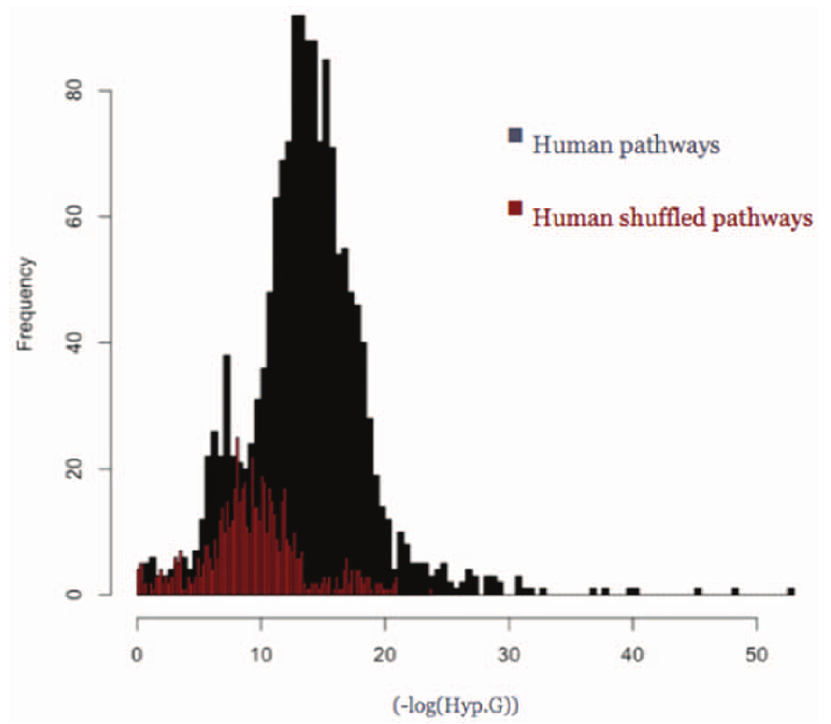
Figure 4. Motif occurrence Hyper-geometric distribution. Hyper-geometric p-value distribution for the number of motif occurrences in true (black) and reshuffled (red) KEGG pathways with respect to the number of motif occurrences in the UniProt dataset for H.sapiens . The p-value=3e-9 approximately corresponds to a false discovery rate of 10%.